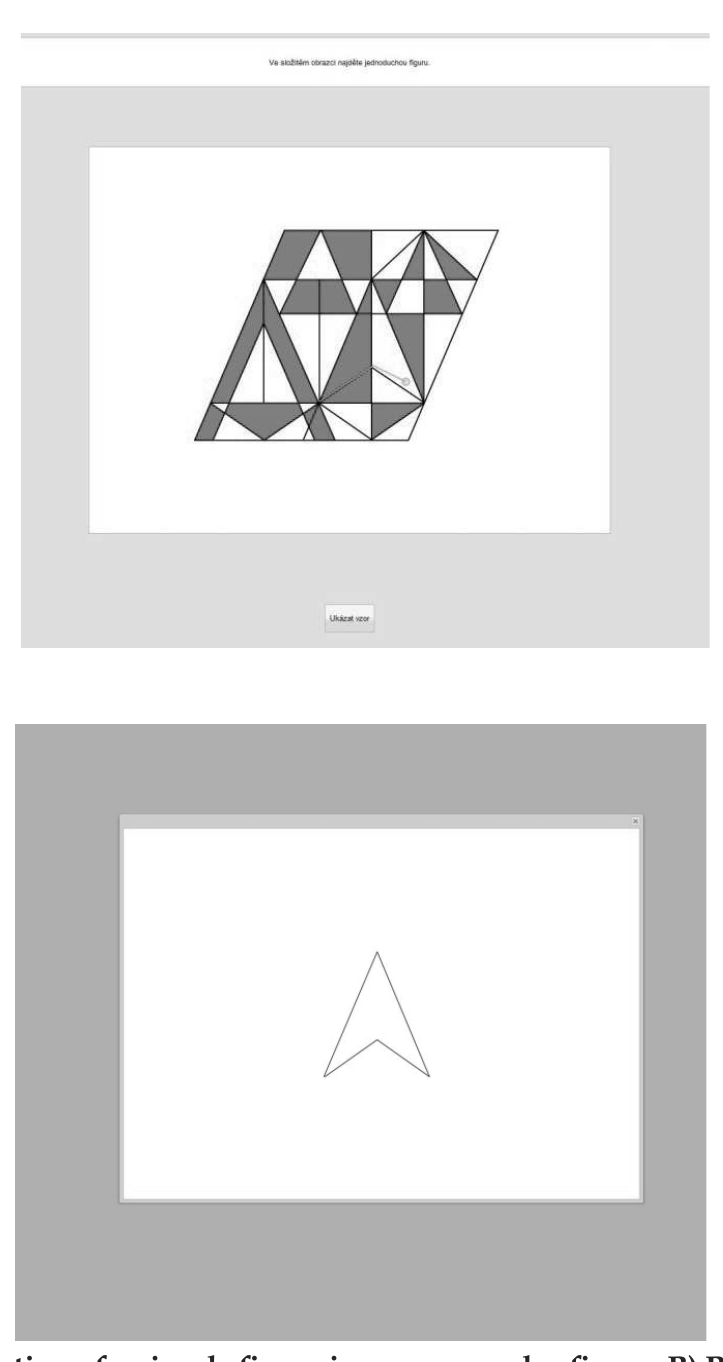
Fig. 8. A) Selection of a simple (cid:222) gure in more complex (cid:222) gure. B) Production of a simple (cid:222) gure and blockading of a complex (cid:222)